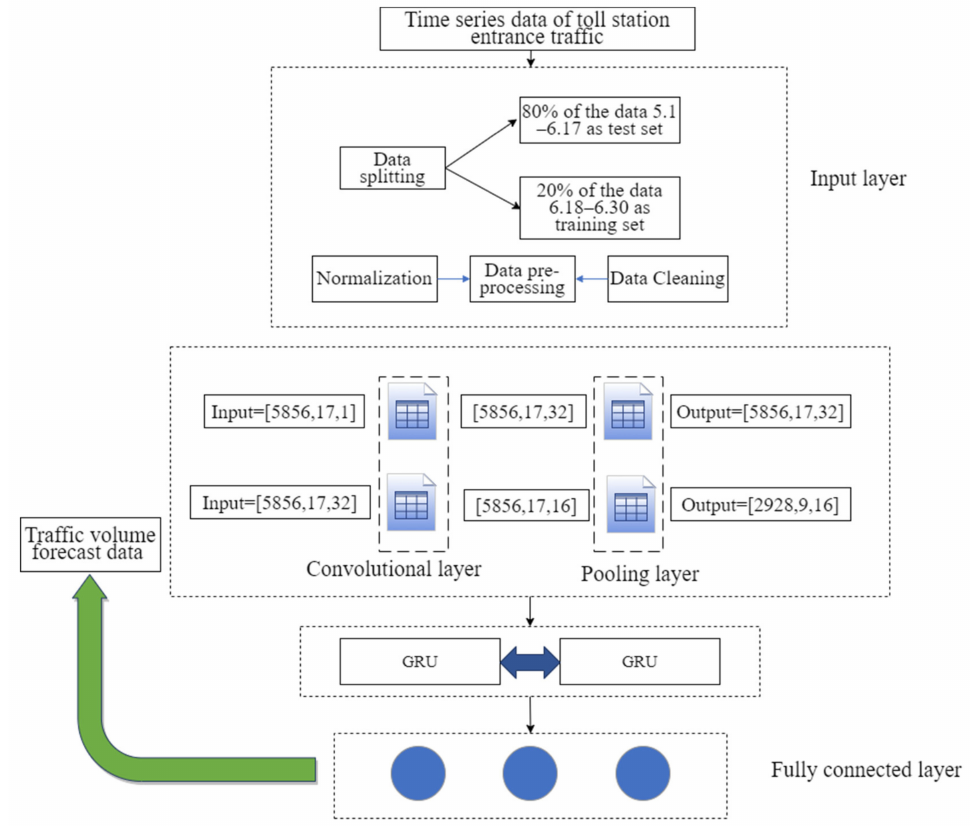
Figure 3. CNN–GRU model framework